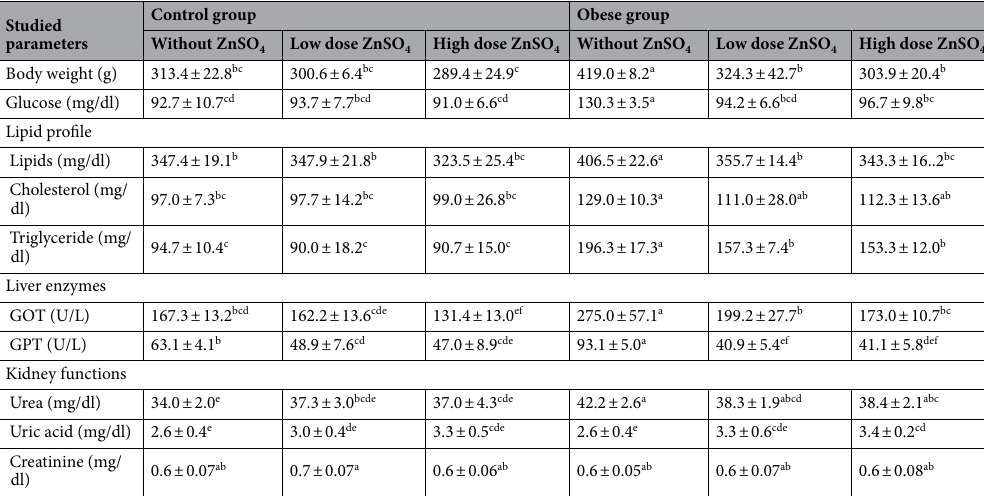
Table 3. Body weight, serum glucose level, lipid profile, liver and kidney functions in control and obese groups without ZnSO 4 tretatment, low dose (15 mg) ZnSO 4 treatment, and high dose (30 mg) ZnSO 4 treatment in male rats. Data was expressed using mean ± SD. Means in the same raw with small common letters are not significant (i.e. means with different letters are significant). SD standard